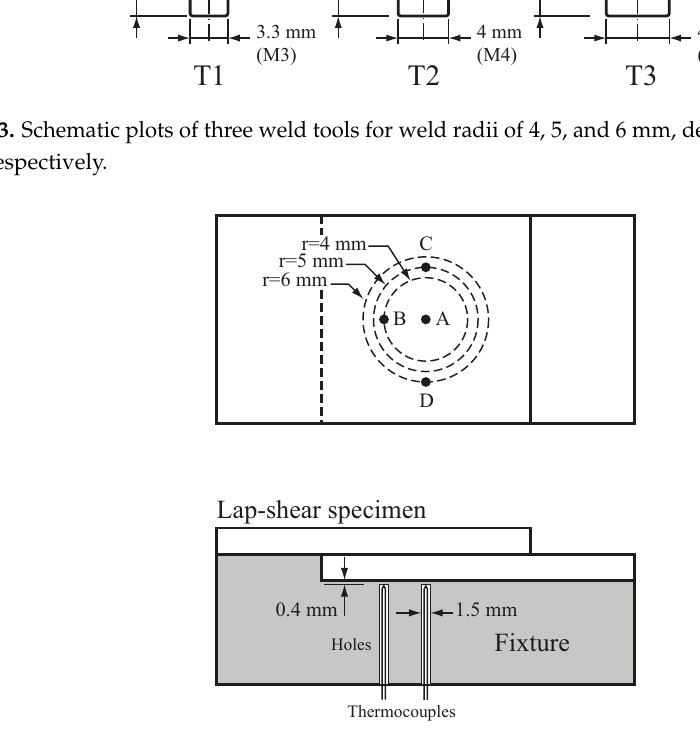
Figure 4. Schematic plots of thermocouples at locations A, B, C, and D in the fixture.